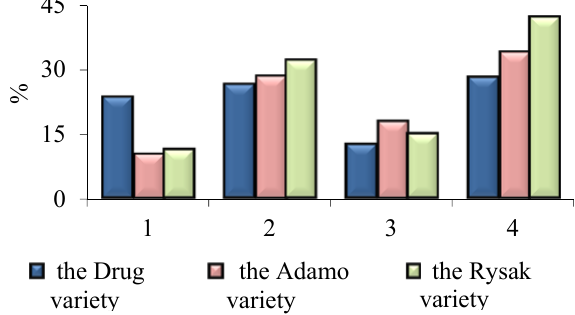
Fig. 5. Fractional composition of the protein complex of the samples of common oat grains: (1) albumins, (2) globulins, (3) prolamines, (4) glutelins.